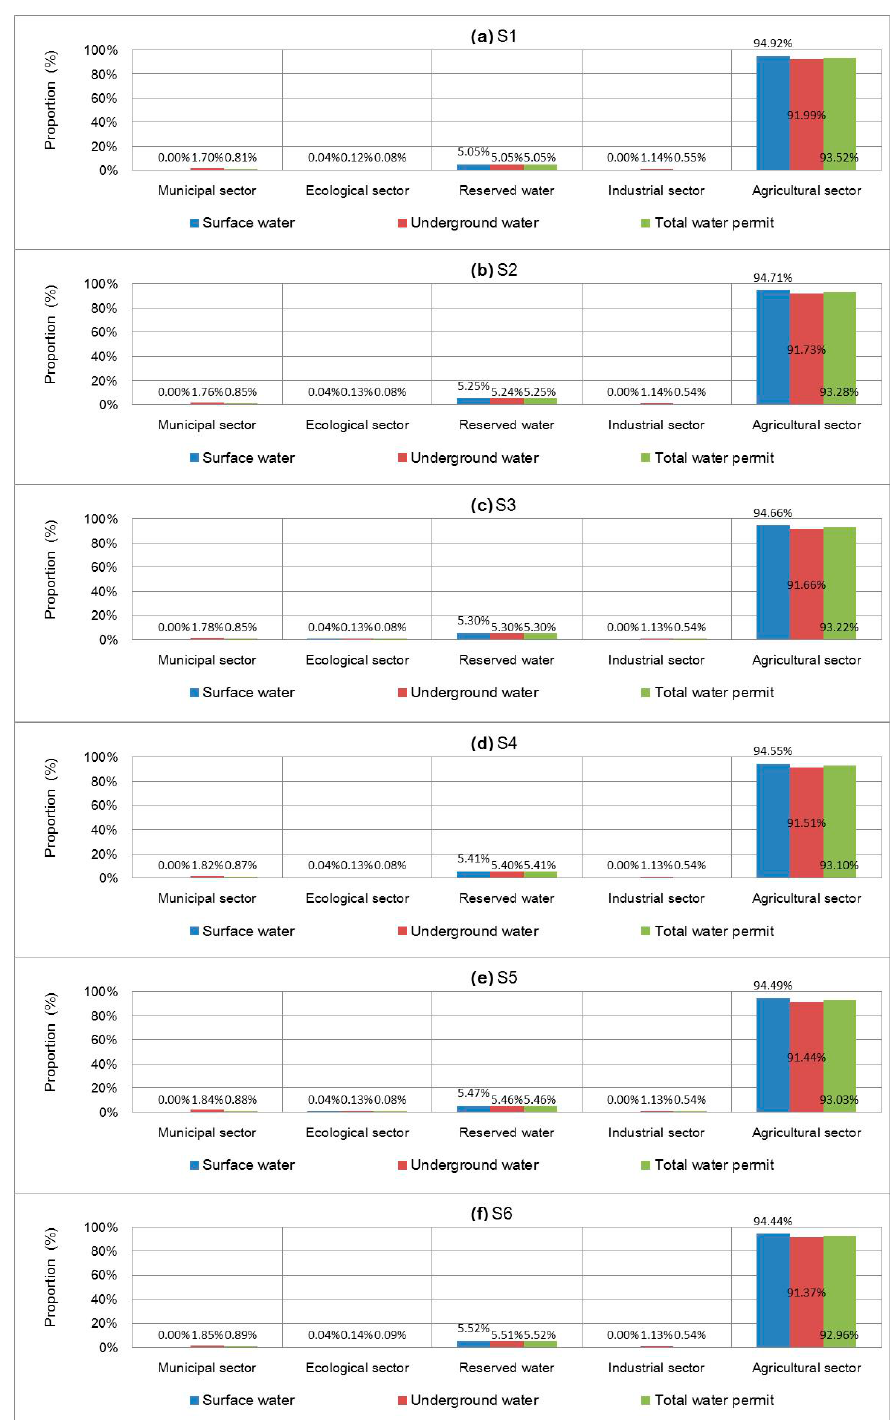
Figure 8. Optimal proportion of water-rights allocation from surface and ground water ( α = 0.9).